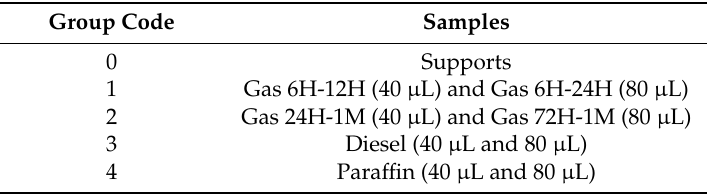
Table 1. Groups stablished a priori for the LDA.